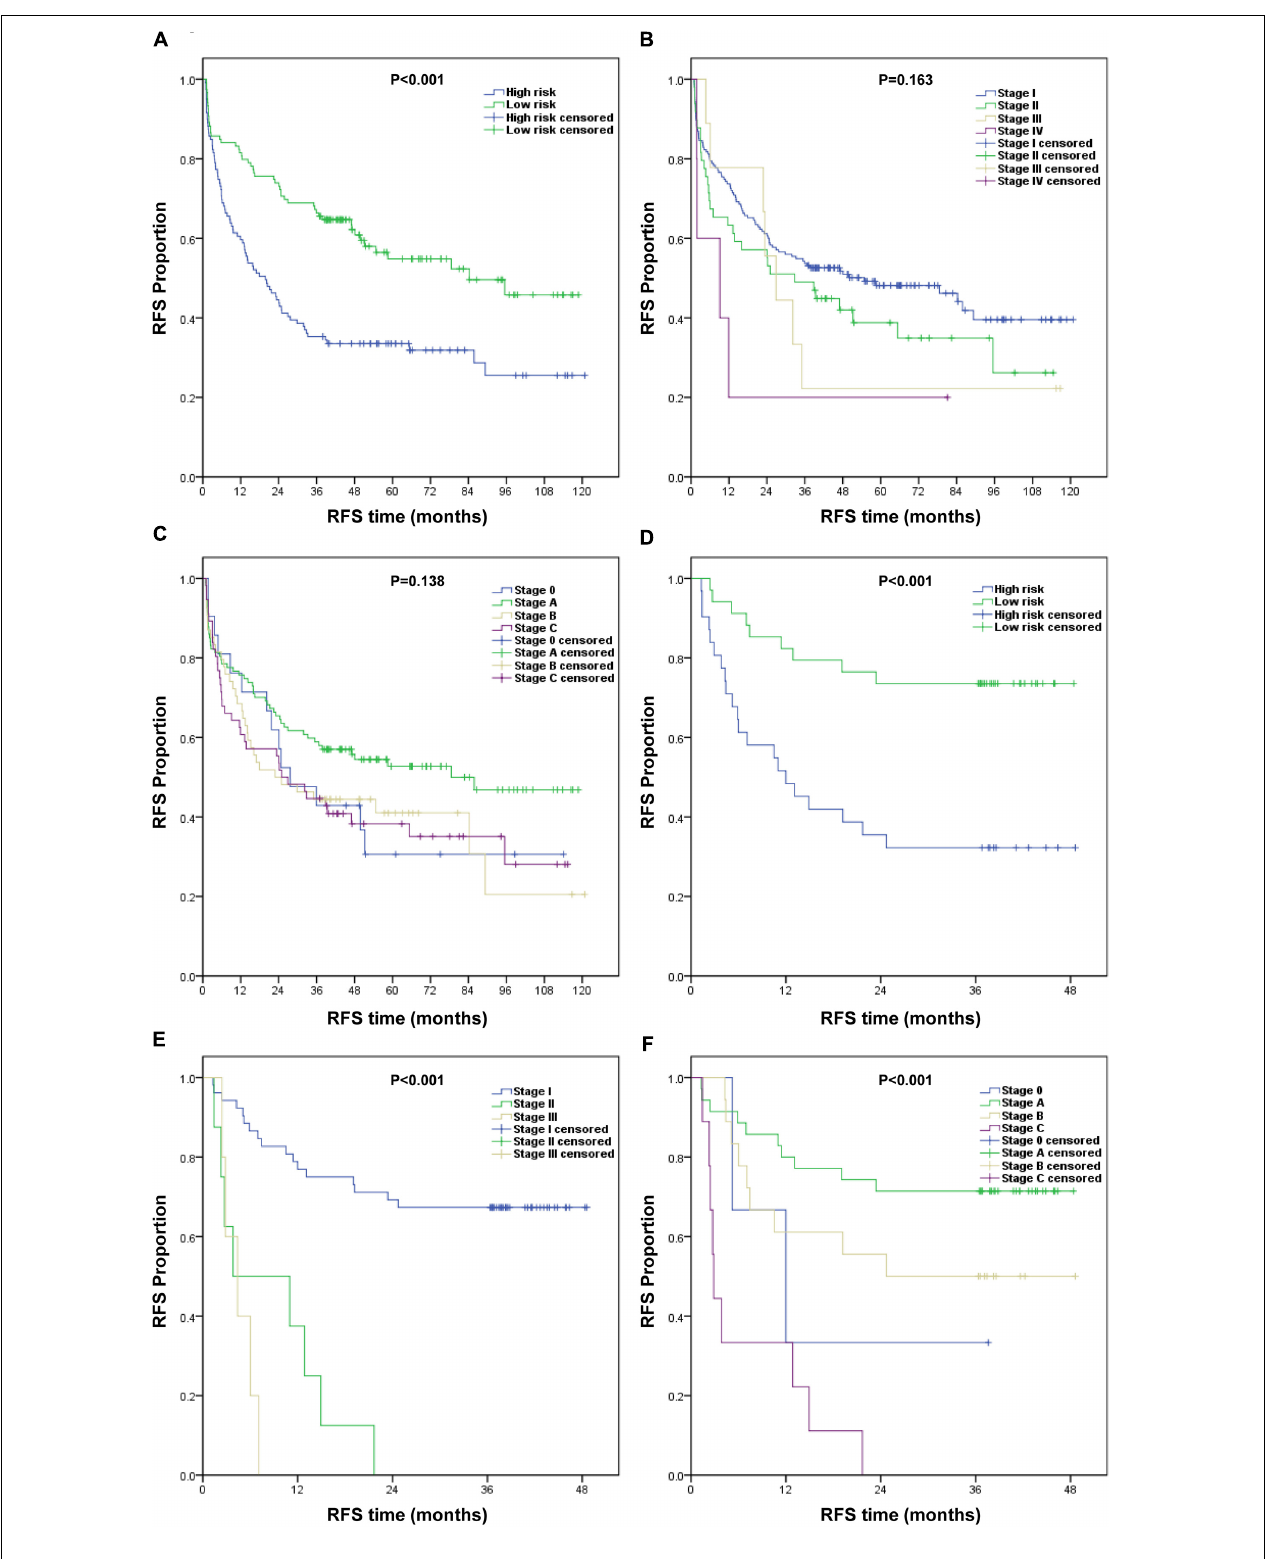
FIGURE 5 | Kaplan–Meier survival curves of RFS for different models. (A–C) Training cohort: (A) nomogram, (B) AJCC8th staging system, and (C) BCLC staging system. (D–F) Validation cohort: (D) nomogram, (E) AJCC8th staging system, and (F) BCLC staging system.